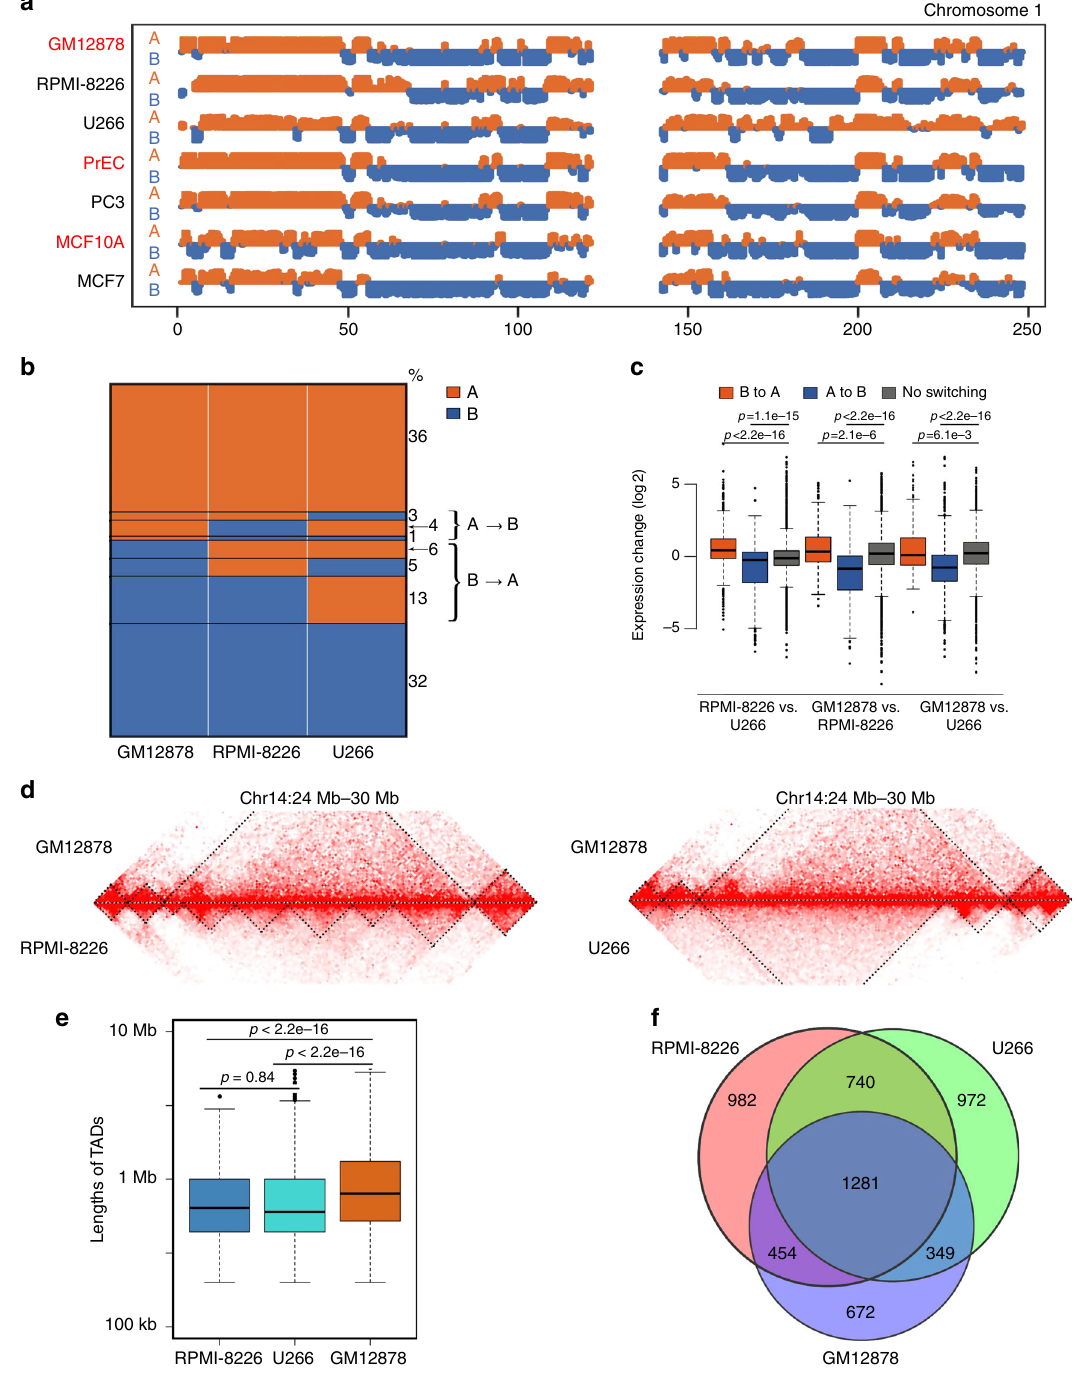
Fig. 4 Reorganization of 3D chromosome is associated with gene expression changes. a The A/B compartments in RPMI-8226 and U266 compared with normal B cells (GM12878) in chromosome 1. b Genome-wide proportions of A/B compartment changes among RPMI-8226, U266 and GM12878 cells. c Boxplots of expression changes of genes grouped by their A/B compartment changes (t-test). d Example of conserved and changed TADs in a region (chr14: 24 Mb-30 Mb) comparing RPMI-8226, U266 and GM12878 cells. e The average size of TADs in multiple myeloma cells compared with GM12878. f The number of conserved and changed TADs in multiple myeloma cells compared with